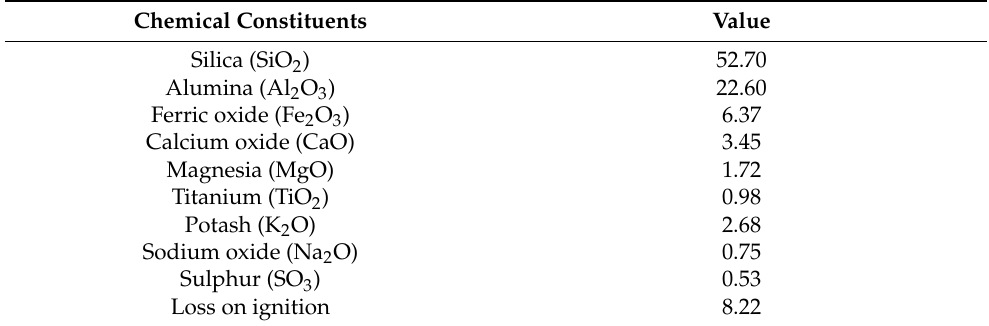
Table 2. Chemical composition of coal gangue by using X-ray Fluorescence (XRF) analysis.